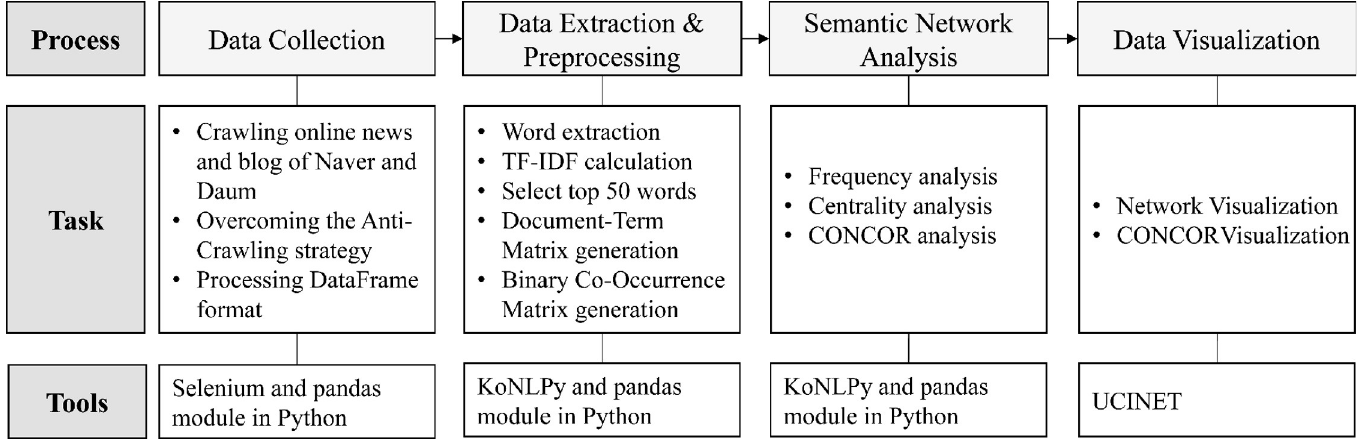
Fig 1. Data collection and analysis process for adolescents’